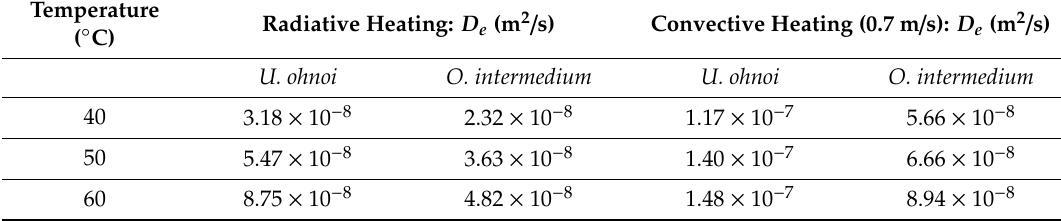
Table 3. E ff ective di ff usivity from radiative and convective drying.